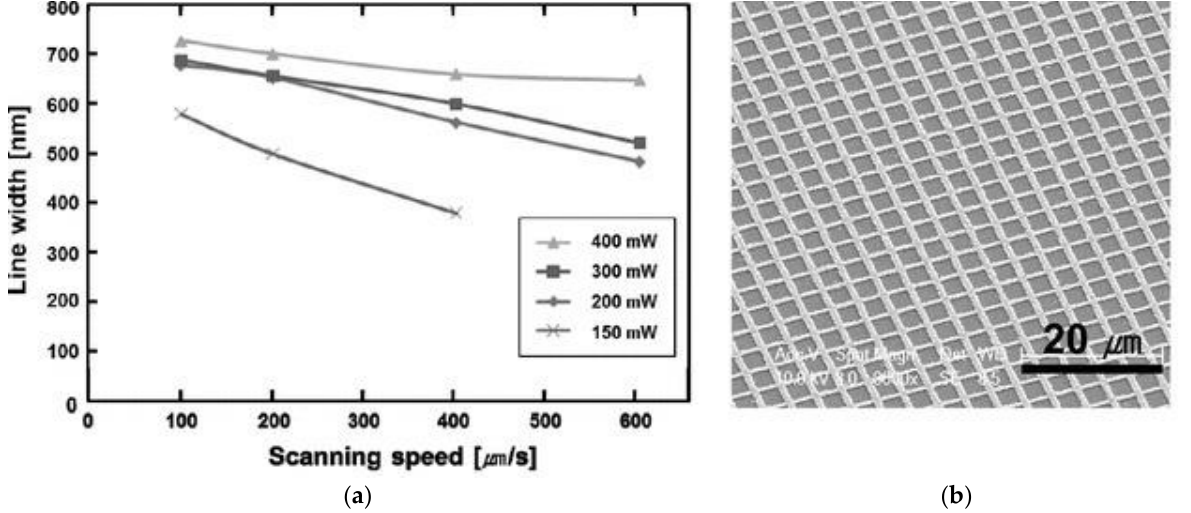
Figure 10. ( a ) Variation of line width as a function of scanning speed at 150, 200, 300, and 400 mW laser powers ( b ) SEM image of the mesh pattern of the printed and sintered silver nanoparticles. Reprinted with the permission of [230].